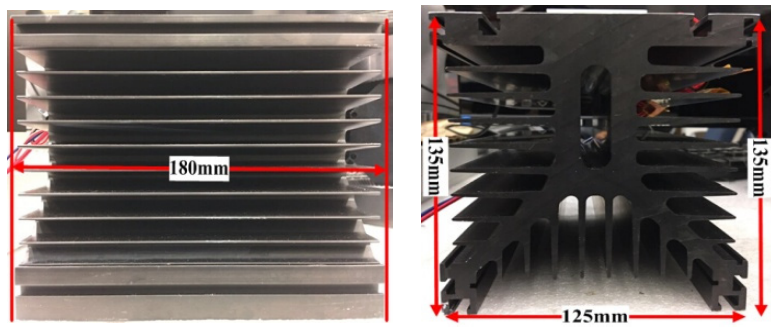
Figure 10. Photograph of the mimicked board.